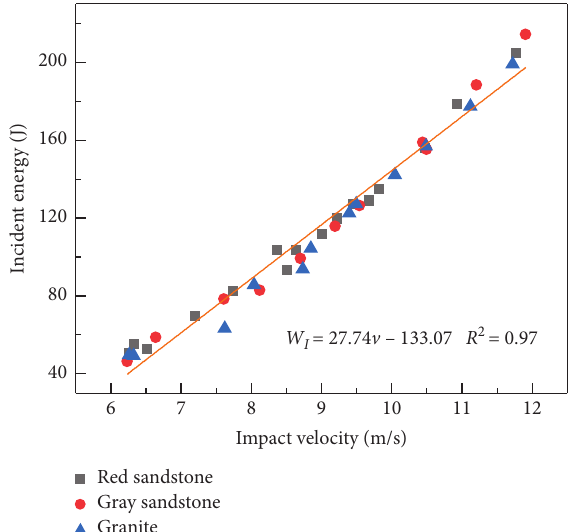
Figure 10: Incident energy-impact velocity diagram.